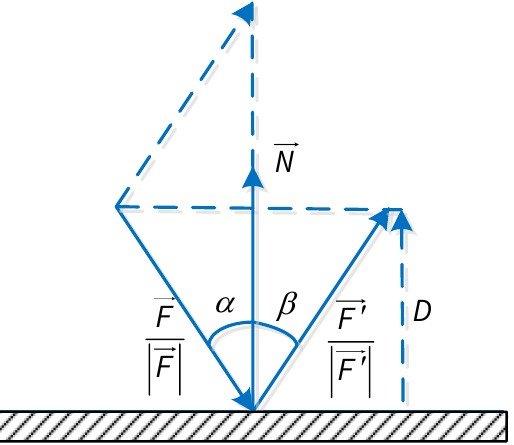
Figure 3. Schematic diagram of the assumption of air-flow wall reflection.